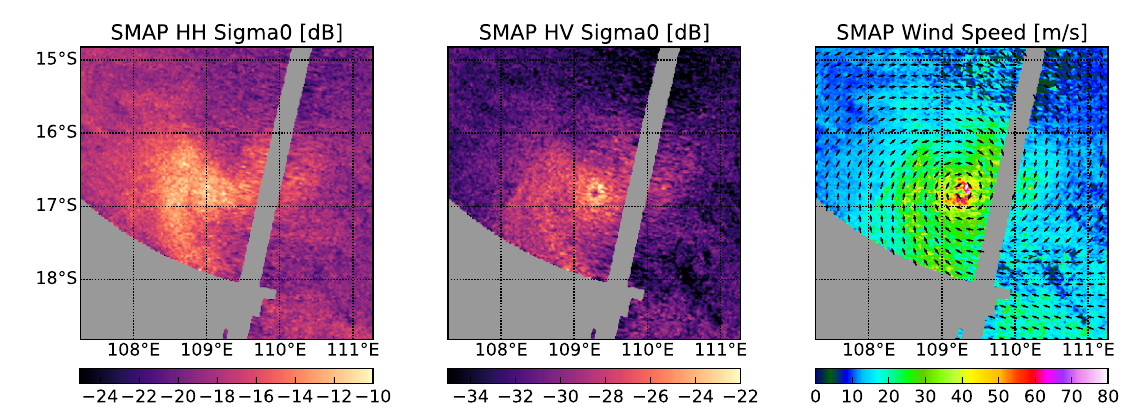
( b ) Cyclone Quang April 29th 2015 approx. 2230 UTC; JTWC best track indicates 59 m/s